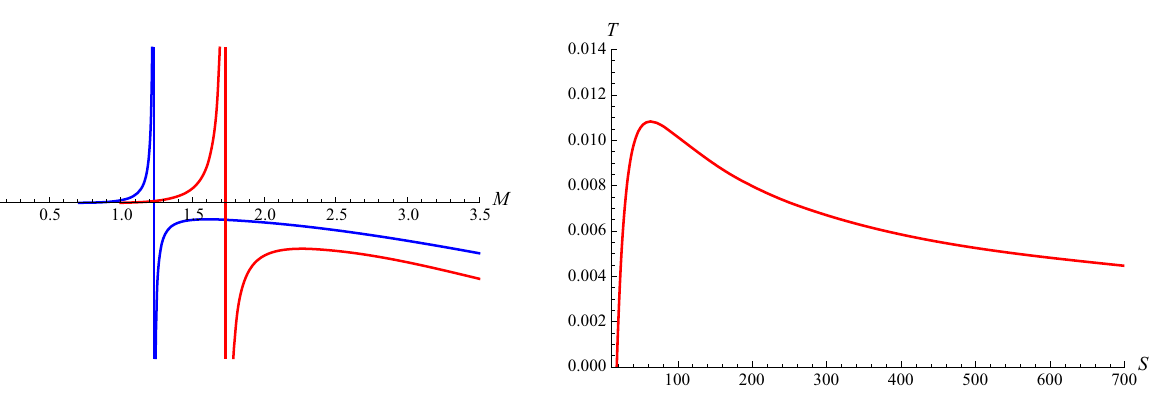
Fig. 5 The relation between the temperature and entropy. We set b = 0 . 5, β = 1 and M p = c = ¯ h =